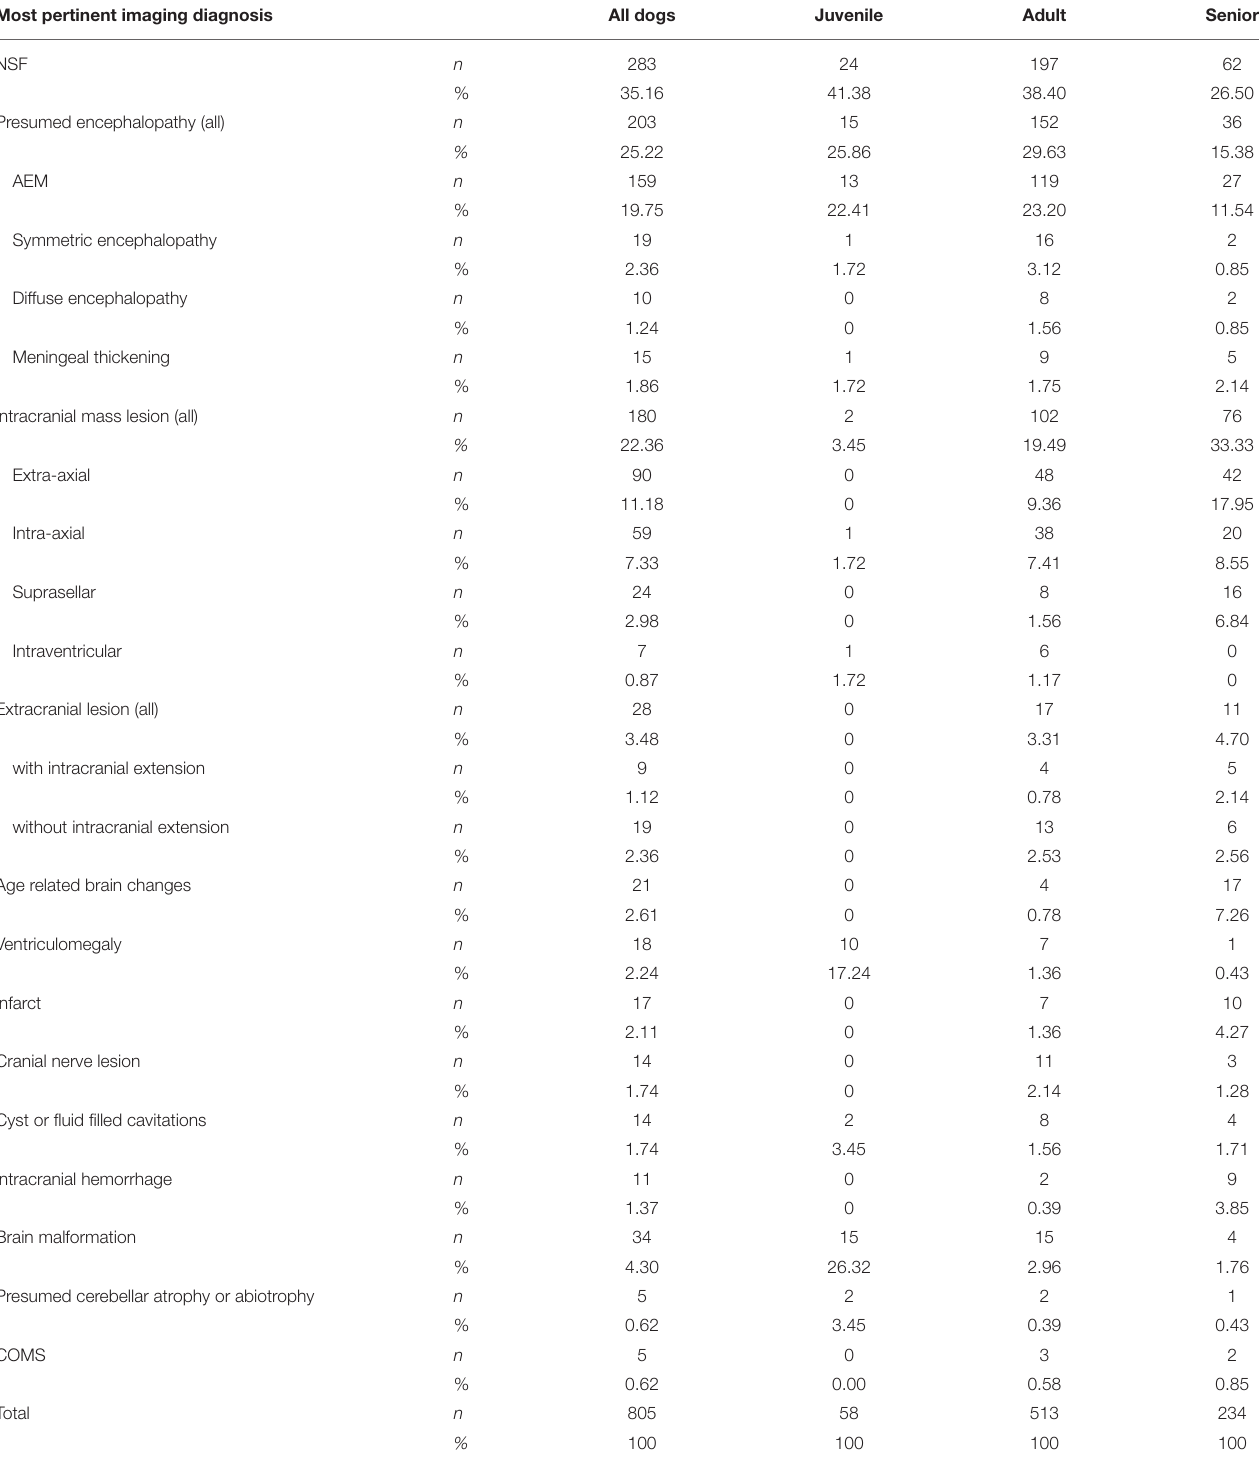
TABLE 1 | Distribution [number ( n ) and percentage (%)] of most pertinent canine brain imaging diagnoses for all dogs and within each age category. Most pertinent imaging